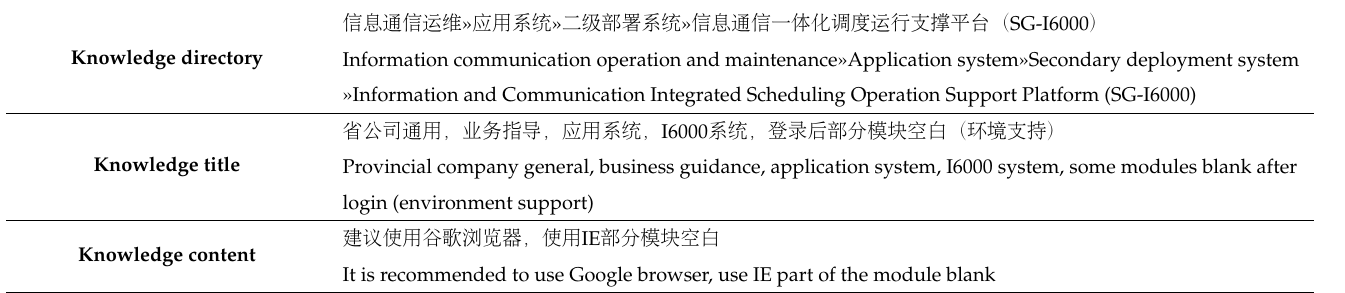
Table 2. Sample data from the power grid dataset. The table shows the original power grid data collected by the Hebei Electric Power